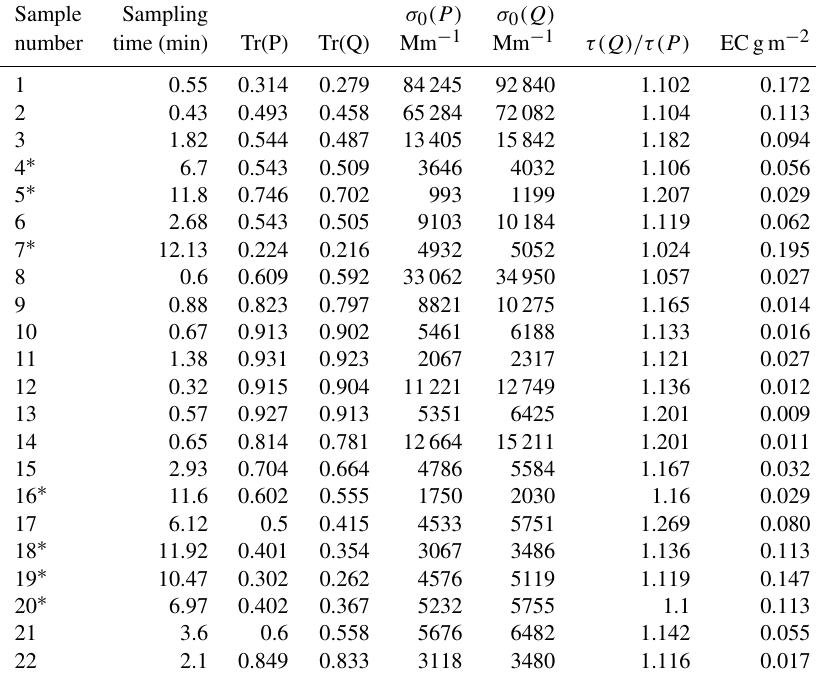
Table 1. Main information on aerosol samples taken during the experiment. Shown are sampling time, transmittances of Pallflex and quartz filters at λ = 530nm at the end of each sample (TR), attenuation coefficient, which is calculated without any loading corrections ( σ 0 ), ratio of optical depths of quartz and Pallflex filters ( τ(Q)/τ(P) ), and EC concentration in the quartz filter (EC). The 1s data from samples denoted by ∗ were used for deriving C ref of quartz filters. Samples 1 and 2 were taken from the mixing chamber without any